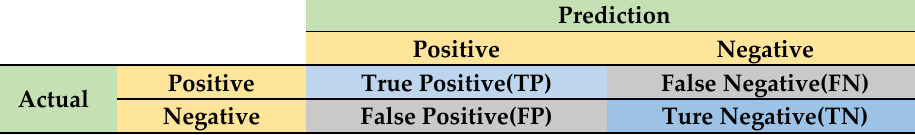
Figure 7. Example of the confusion matrix.